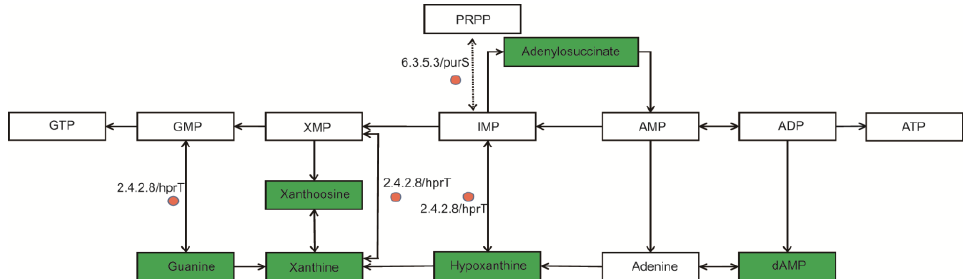
Figure 10. Purine metabolic network in pathways based on multi-omics analysis of heat resistance in RS047-wl. Colored rectangles are the relative content changes of metabolites in RS047-wl compared to WT RS047 (red, higher content; green, lower content; white, no significant change); the colored circles represent the gene expression levels in RS047-wl compared to WT RS047 (green, lower content; white, no significant change).